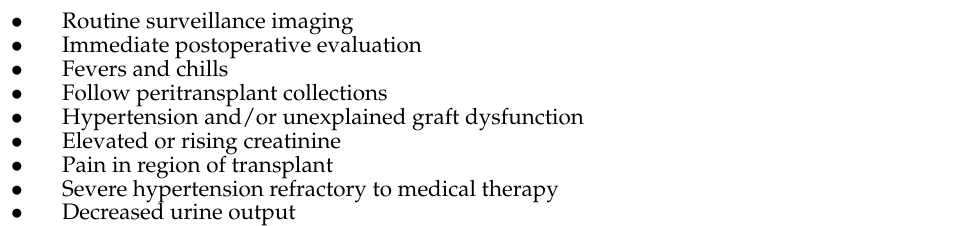
Table 2. Indications for kidney transplant